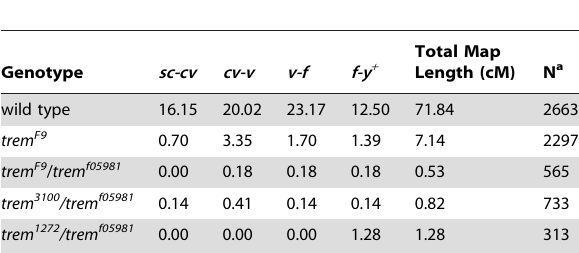
Table 3. Frequency of recombination on the X chromosome in genomic trem alleles.